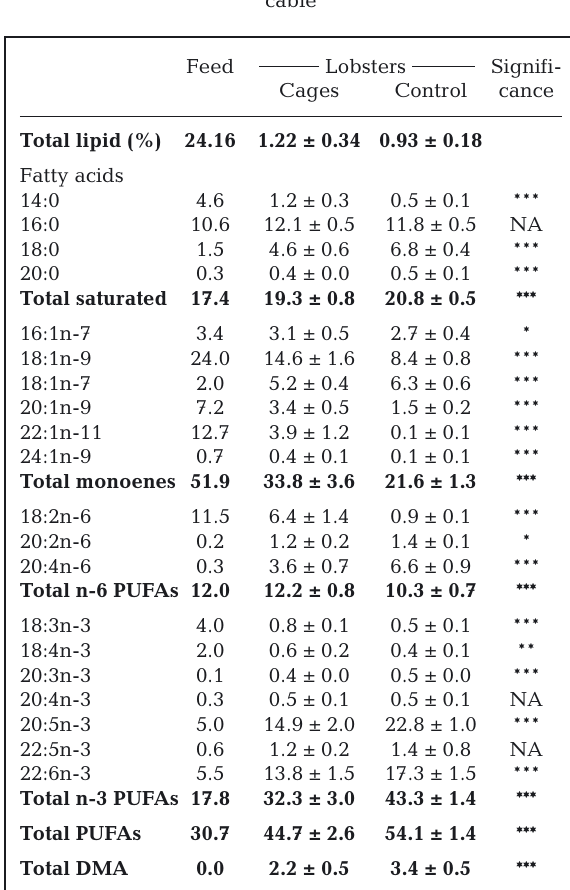
Table 1. Fatty acid (FA) profile (% FA of total lipid) of lobster muscle. Values are means (±SD). Last column